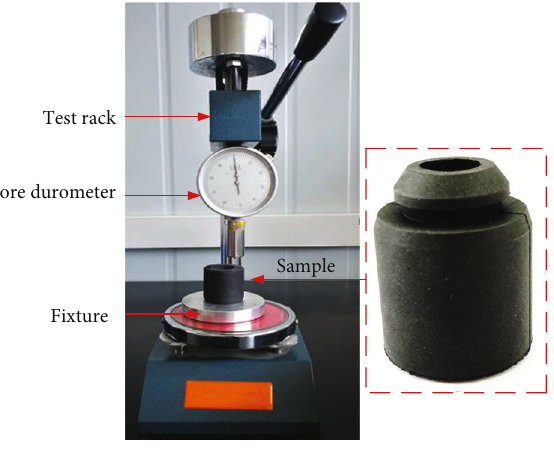
Figure 8: Test rig of hardness. Table 1: Thermal oxygen aging time under di ff erent